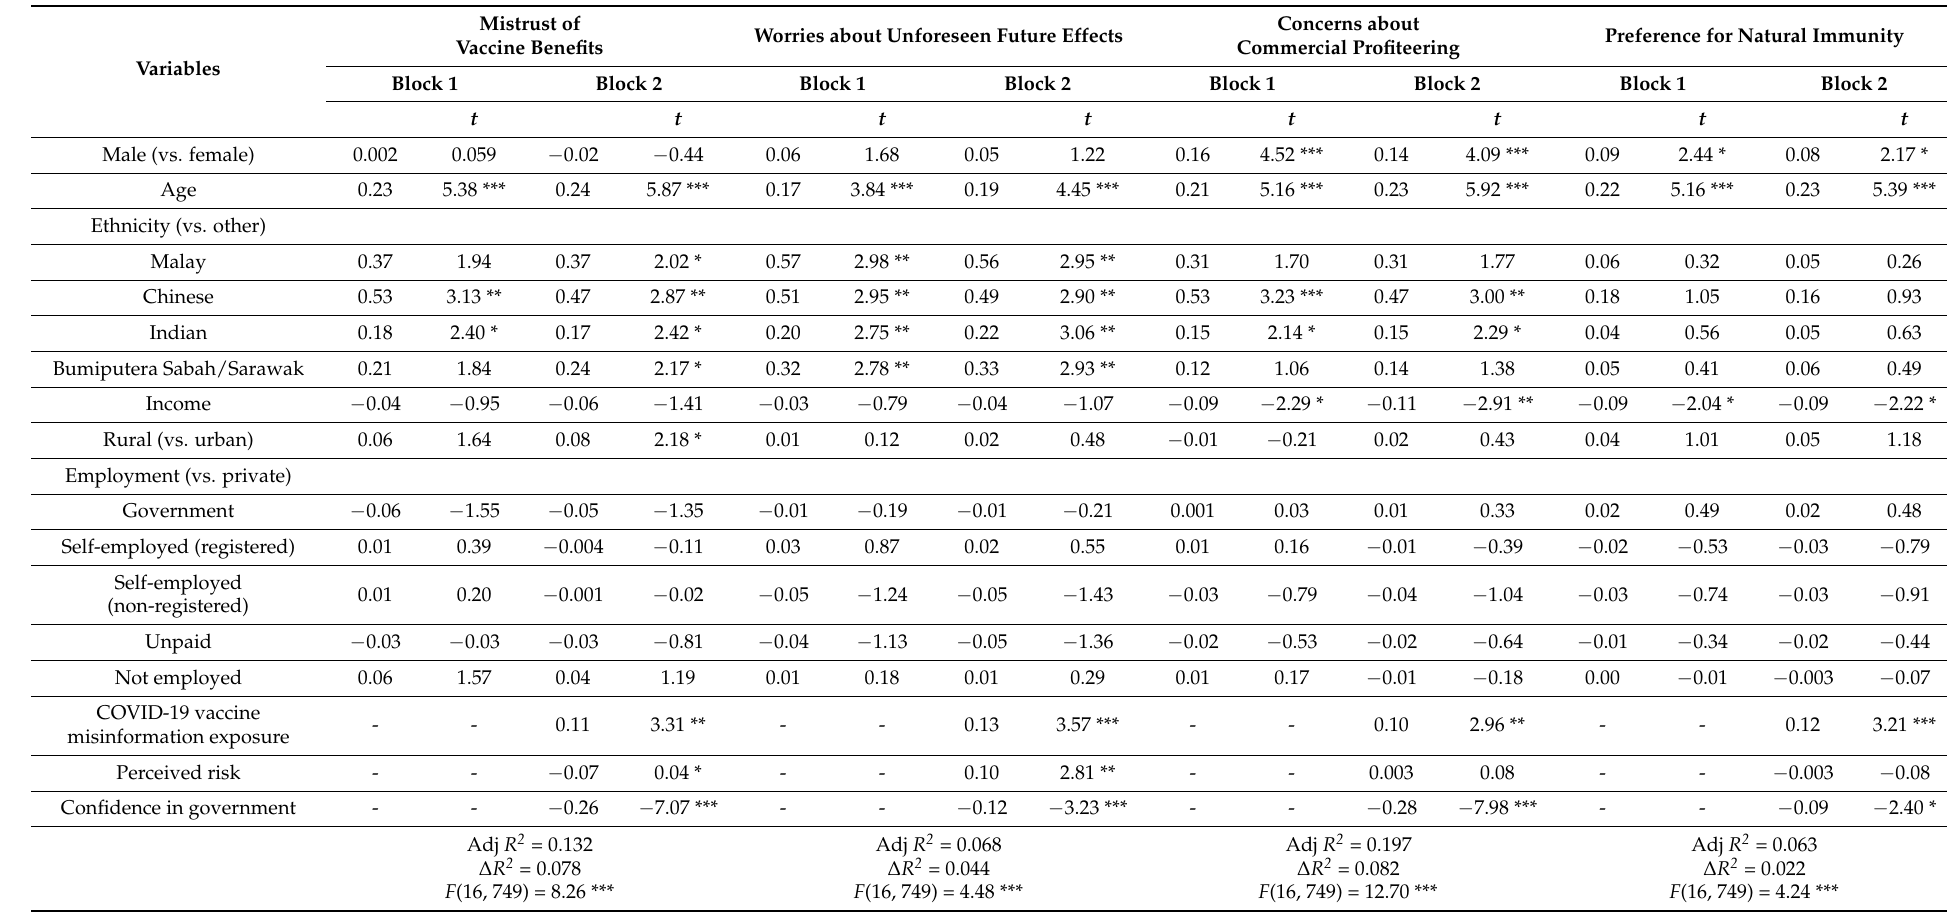
Table 9. Results of regression models predicting four domains of negative attitudes towards the COVID-19 vaccine. Mistrust of Vaccine Variables